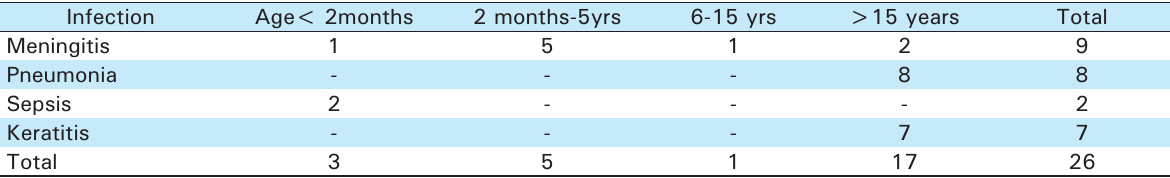
Table 1. Pattern of Pneumococcal infections in different age groups in BPKIHS hospital Infection Pneumonia